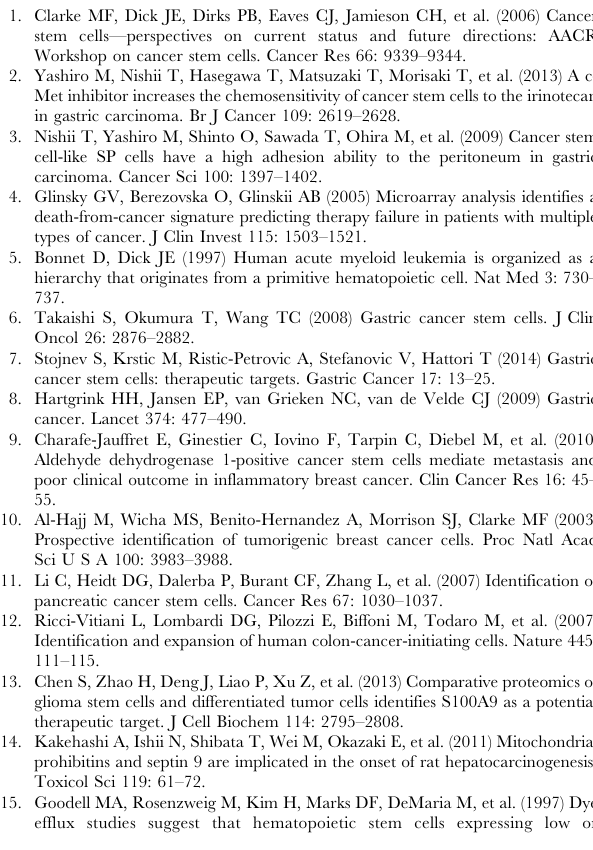
Figure S3 Expression of RBBP6 and ALDOA. The expression level of RBBP6 and ALDOA was high in CUM-12/ SP and OCUM-2MD3/SP cells, in comparison with that OCUM- 12 and OCUM-2MD3 cells.